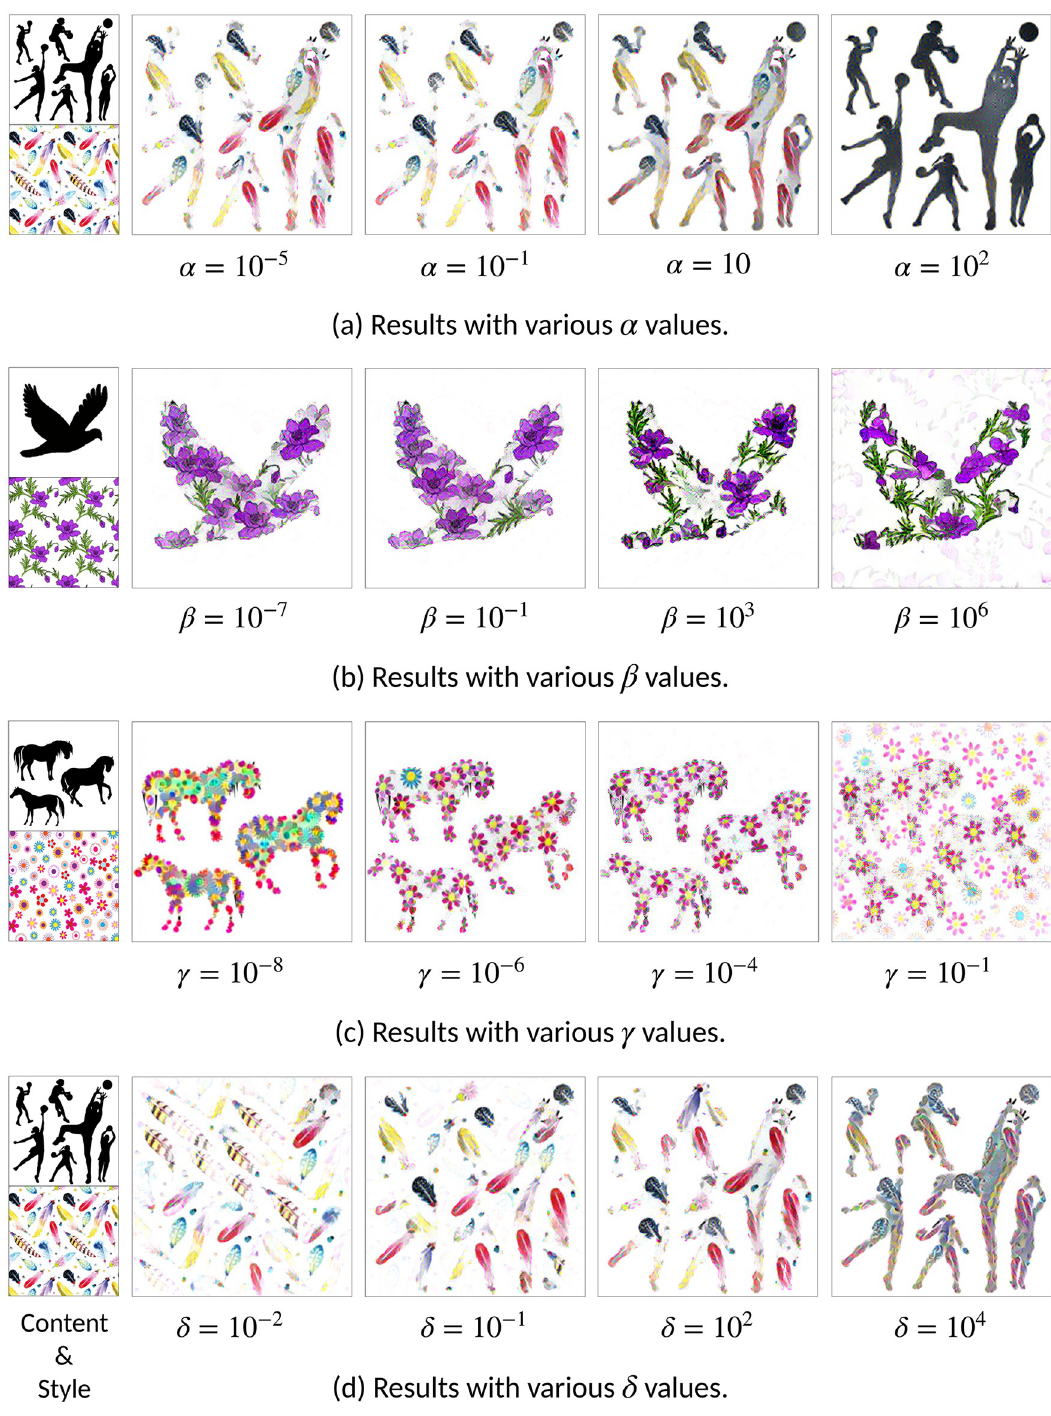
Fig 12. Style transferring results with various